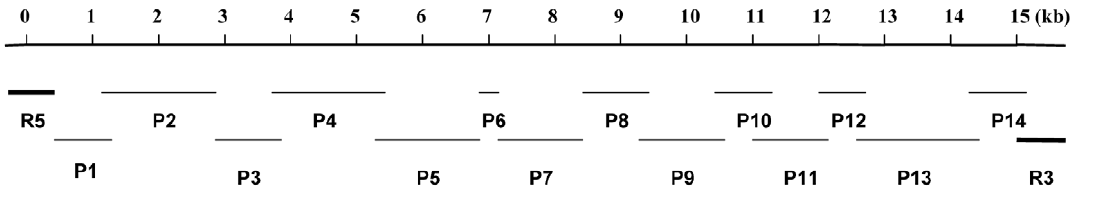
Figure 1. Schematic diagram of clones used to compile the complete CmRyR cDNA sequence. The top line indicates the full-length CmRyR cDNA in kilobases. Thin lines (P1–P14) represent CmRyR cDNA clones obtained by RT-PCR. Solid lines (R5 and R3) represent CmRyR cDNA clones obtained by RACE.